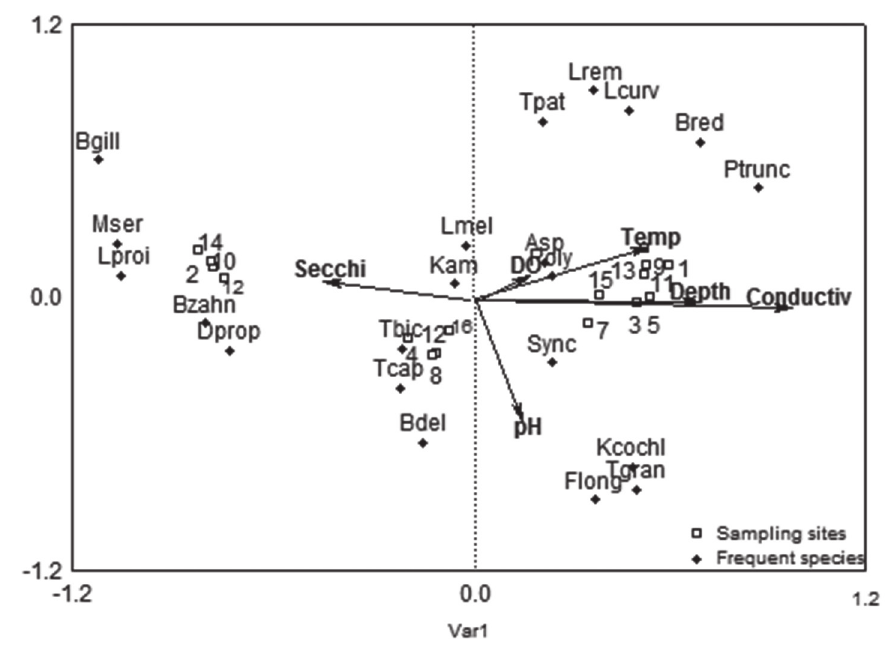
Figure 6 - CCA Ordination Diagram displaying physical and chemical variables (arrows), sampling sites (□) and frequent species occurrence (◊). Numbers (1 to 16) read: Even numbers= Flooding of 2007 and 2008; Odd numbers = Receding period of 2006 and 2007; 1 to 4= Station 1; 5 to 8= Station 2; 9 to 12 = Station3; 13 to 16 = Station 4. Biotic variables read: Mser = Macrochaetus sericus ; Lproi = Lecane proiecta ; Bgill = Brachionus gillardi ; Dprop = Dipleuchlanis propatula ; Bzahn = Brachionus zahniseri ; Bdel = Bdloidea; Tcap = Trichocerca capucina ; Tbic = Trichocerca bicristata ; Kam = Keratella americana ; Lmel = Lecane melini ; Sync = Synchaeta oblonga ; Poly = Polyarthra sp; Asp = Asplancna sieboldi ; Tpat = Testudinella patina ; Lrem = Lecane remanei ; Lcurv = Lecane curvicornis; Flong = Filinia longiseta ; Tgran = Trichocerca similis grandis ; Kcochl = Keratella cochlearis ; Bred = Brachionus rzahniseri var. reductus ; Ptrun = Plesoma truncatum. Physical and chemical variables: Secchi = transparency; DO = dissolved oxygen; pH = pH; Depth = total depth; Conductiv = electrical conductivity; Temp = water